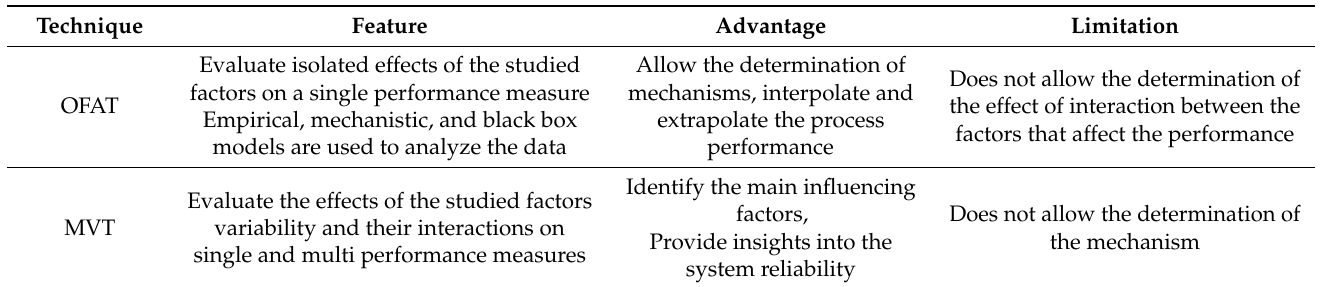
Table 2. Comparison between the optimization techniques (Reprinted with permission from